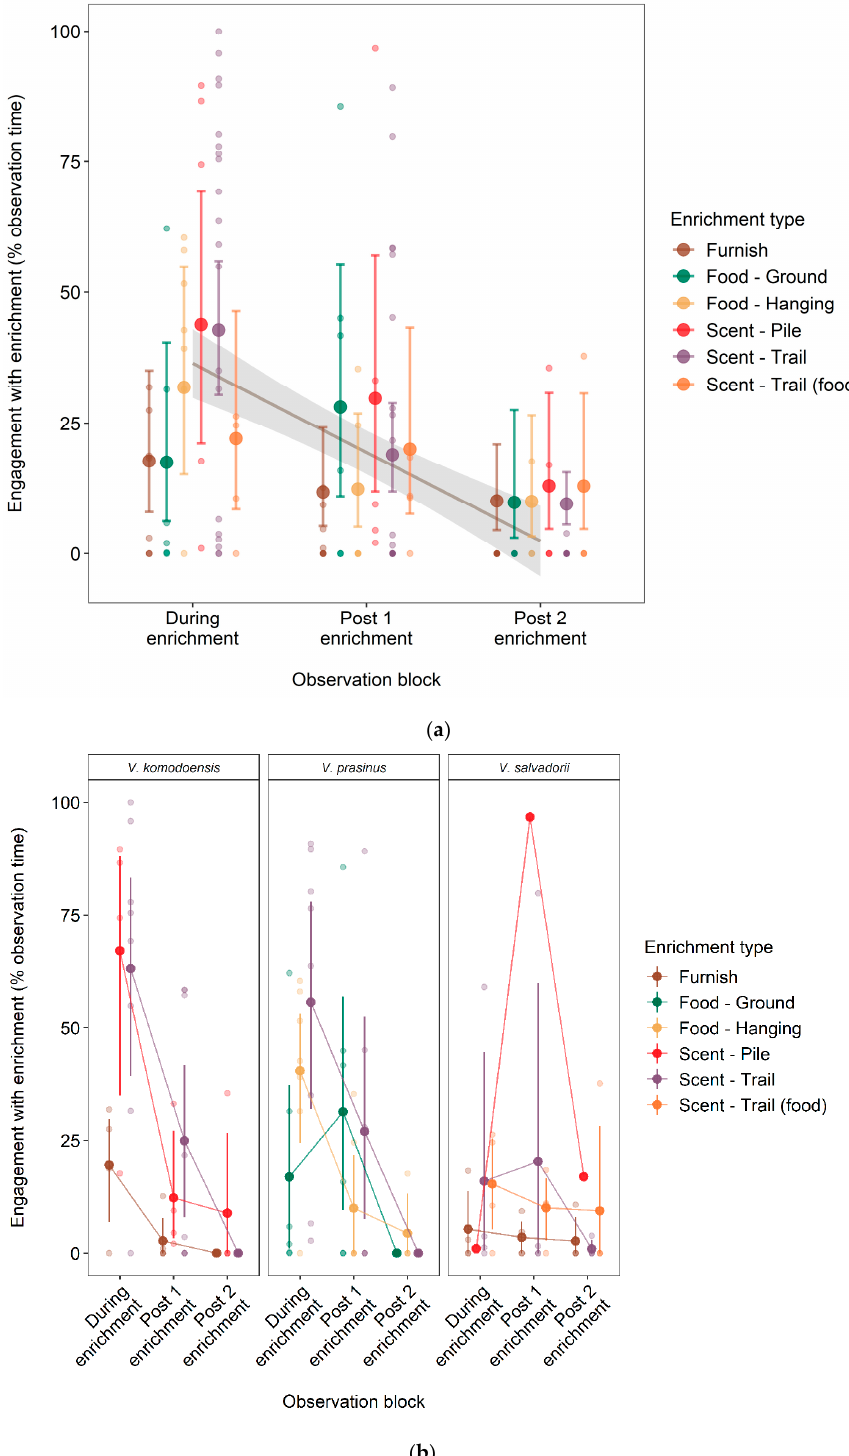
Figure 2. ( a ) Engagement with enrichment items over time in three varanid lizard species. Large points and error bars represent predicted means ± standard error from a Beta GLMM. Small points represent individual trials (raw data). Line of best fit through raw data to indicate trend. ( b ) Species- specific engagement with enrichment items in three varanid lizard species. Large points and error bars represent raw data means and 95% non-parametric bootstrap (10,000 samples) confidence in- tervals. Small points represent individual trials (raw data).